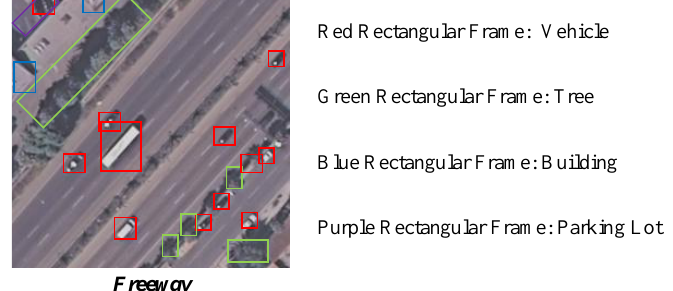
Figure 2. Complex contents within one remote sensing image. The main body of this remote sensing image is “Freeway”. Apart from “Freeway”, there are also “Vehicle”, “Tree”, “Building”, “Parking lot”, etc. In addition, the scales of the same targets are